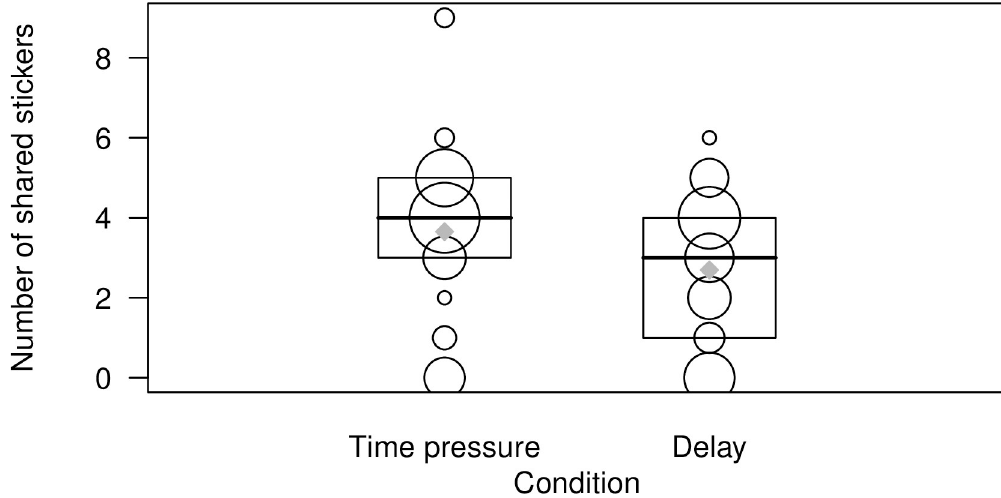
Fig 2. Depiction of the main effect of condition on the number of stickers shared. Bigger bubbles represent higher numbers of participants. Lines represent medians, boxes represent quartiles, diamonds represent means.